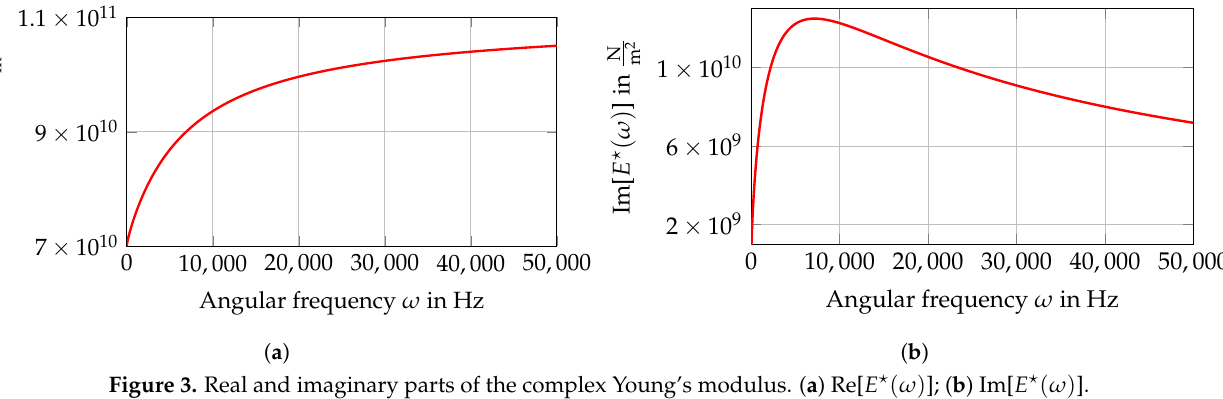
Figure 3. Real and imaginary parts of the complex Young’s modulus. ( a ) Re[ E (cid:63) ( ω ) ]; ( b ) Im[ E (cid:63) ( ω )